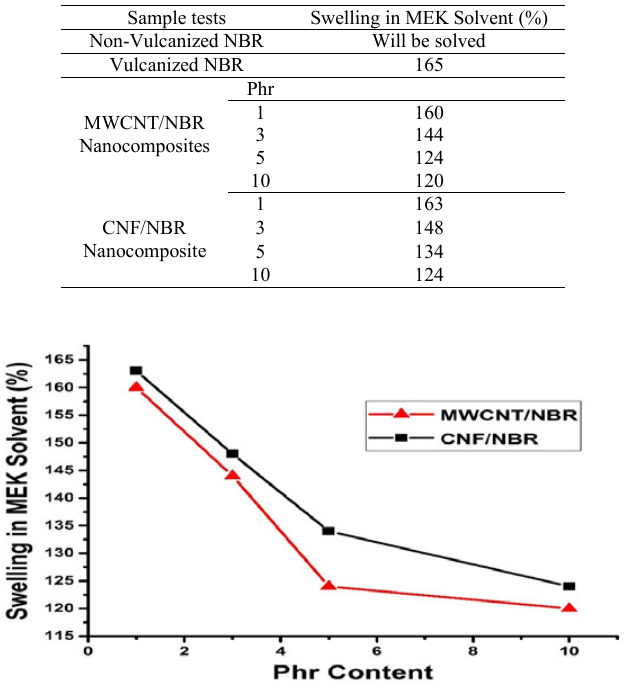
Fig. 7. Chemical Properties evaluation of fabricated nanocomposites versus Phr